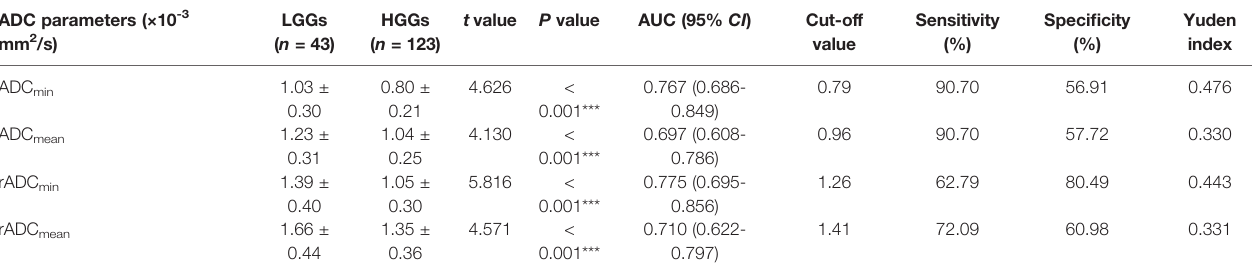
TABLE 4 | Comparison and ROC curve analysis of ADC parameters between LGGs and HGGs.